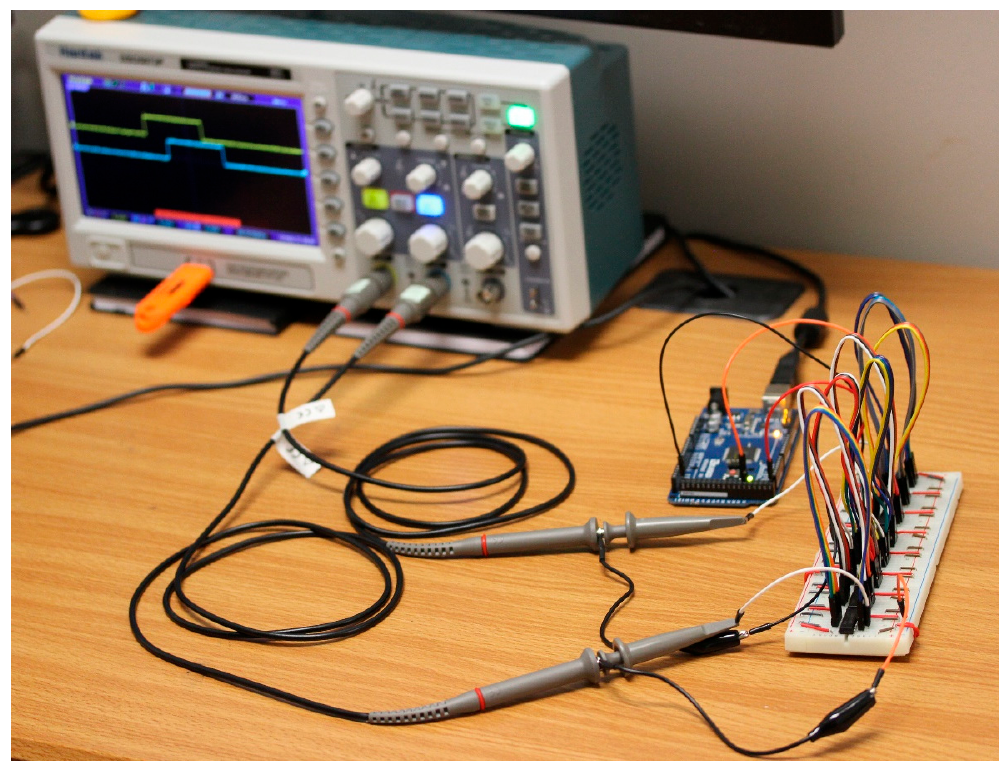
Figure A2. Hardware network implementation—side view.